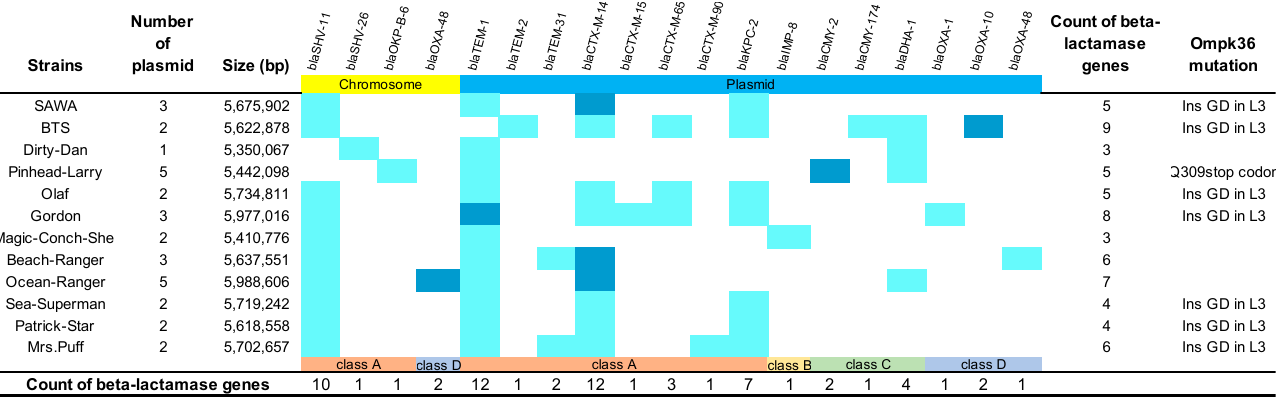
Figure 1. Distribution of carbapenem-resistant determinants in Klebsiella pneumoniae strains. This heat map illustrates the distribution of β -lactamase genes, their copy numbers, and OmpK36 mutation among K. pneumoniae strains from our study. Each row represents a single strain, and each column represents a specific β -lactamase gene. The color scale ranges from light blue, indicating a single copy of the gene, to dark blue, indicating two copies of the gene. The β -lactamase genes are divided into four classes (A to D) based on their amino acid sequence homology and functional properties. Class A, C, and D enzymes are serine-based, while class B enzymes are metallo- β - lactamases [12].